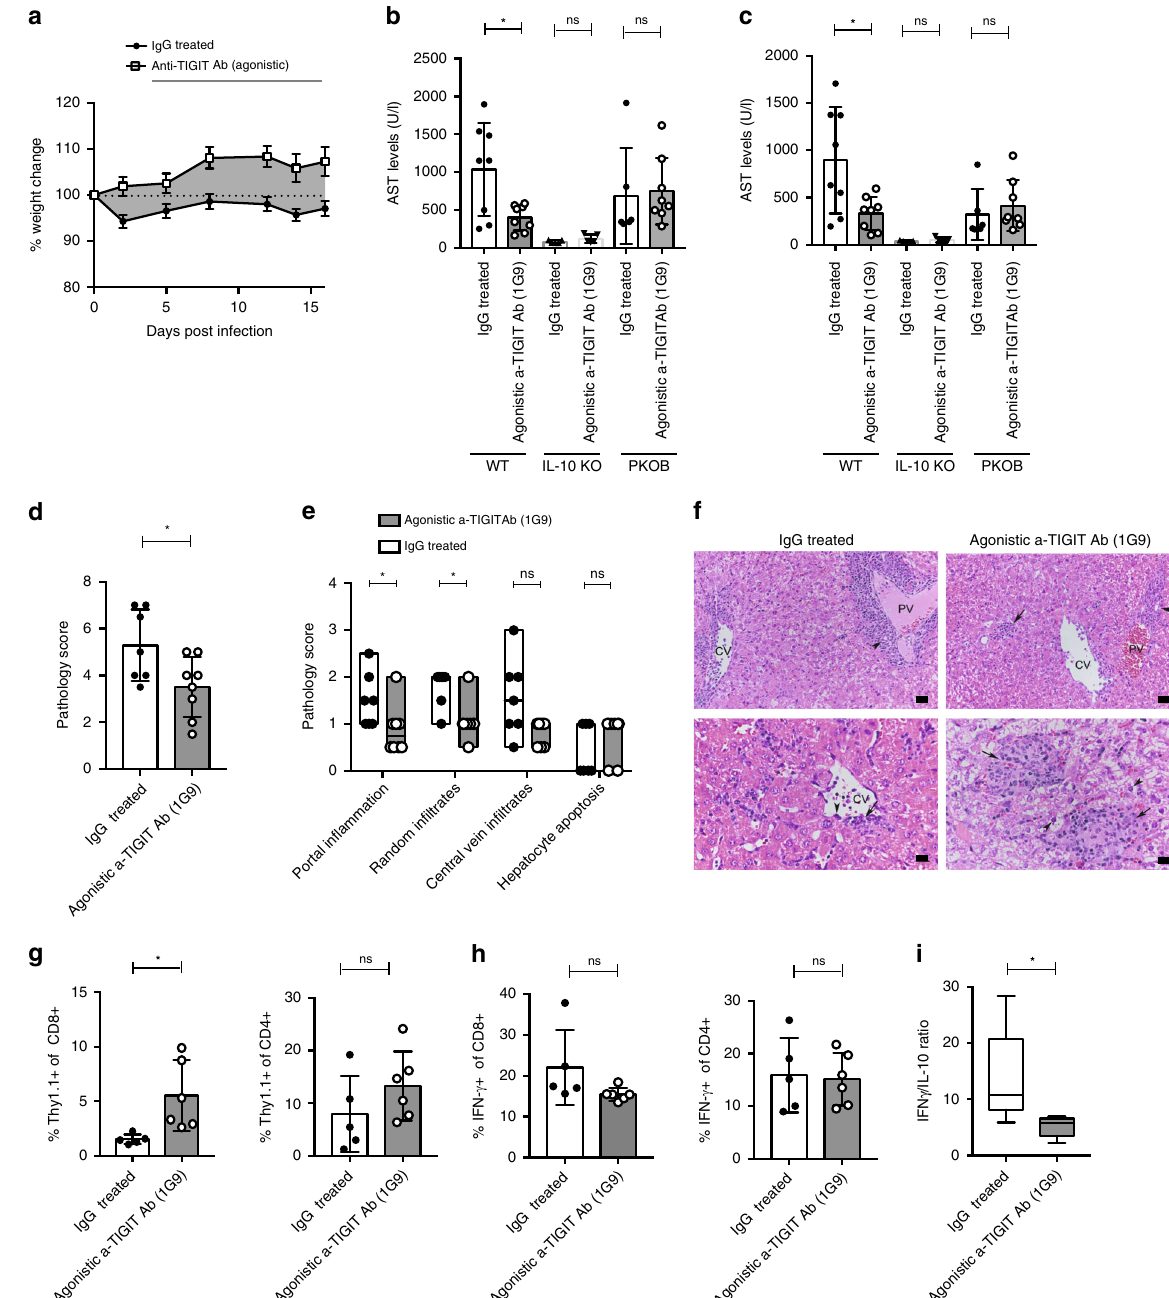
Fig. 6 TIGIT engagement limits immune-mediated tissue pathology in the liver after acute virus challenge. C57BL/6, Thy1.1-IL-10 reporter, IL-10 KO, or PKOB mice were infected with 1 × 10 5 FFU LCMV clone 13 i.v. and treated with 100 μ g control IgG1 or anti-TIGIT Ab (1G9) on days 0, 2, 4, and day 10 i.p. a The body weight of acutely infected mice over the course of infection with or without anti-TIGIT Ab (1G9) treatment is shown ( n = 10). Serum levels of AST ( b ) and ALT ( c ) quanti fi ed by enzymatic activity assay on day 14 p.i. from WT, IL-10 KO, and PKOB mice are shown ( n = 5 – 8). d – f Tissue damage was assessed in liver sections 14 days after infection using hematoxylin and eosin (H&E) staining. Overall pathology ( d ), classi fi cation of histopathological damages ( e ) and representative light microscopy images ( f ) are depicted ( n = 7 – 8). Arrows indicate leukocyte recruitment and in fi ltration or dying hepatocytes. CV central vein, PV portal vein. Scale bar = 20 μ m. g – i Cytokine production by T cells in the liver of IgG1 and anti-TIGIT Ab (1G9)-treated mice was determined by FACS on day 14 p.i. g Absolute numbers of IFN- γ + CD8 + and CD4 + T cells after anti-CD3 re-stimulation. h Frequency of IL-10- Thy1.1 + CD8 + and CD4 + T cells ( i ) and the ratio of total IFN- γ + to IL-10 + CD8 + T cells are displayed ( n = 5 – 9). Pooled data from two independent experiments are shown. Each symbol in the scatter plot represents an individual mouse, and bar graphs indicate the mean value ± SD. Statistical values p < 0.05 (*), p < 0.01 (**), p < 0.005 (***), ns (not signi fi cant, p > 0.05) determined by Student ’ s t test (two experimental groups) or one-way ANOVA (more than two experimental groups). Histopathological data were evaluated using two-tailed Mann – Whitney